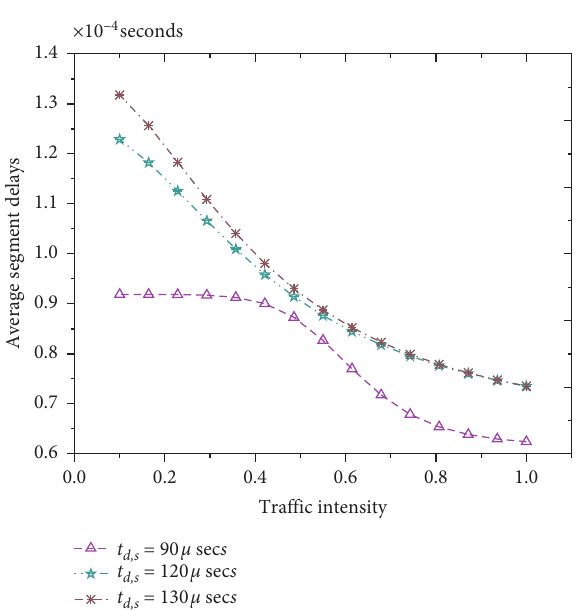
Figure 9: Average segment (packet) delays end to